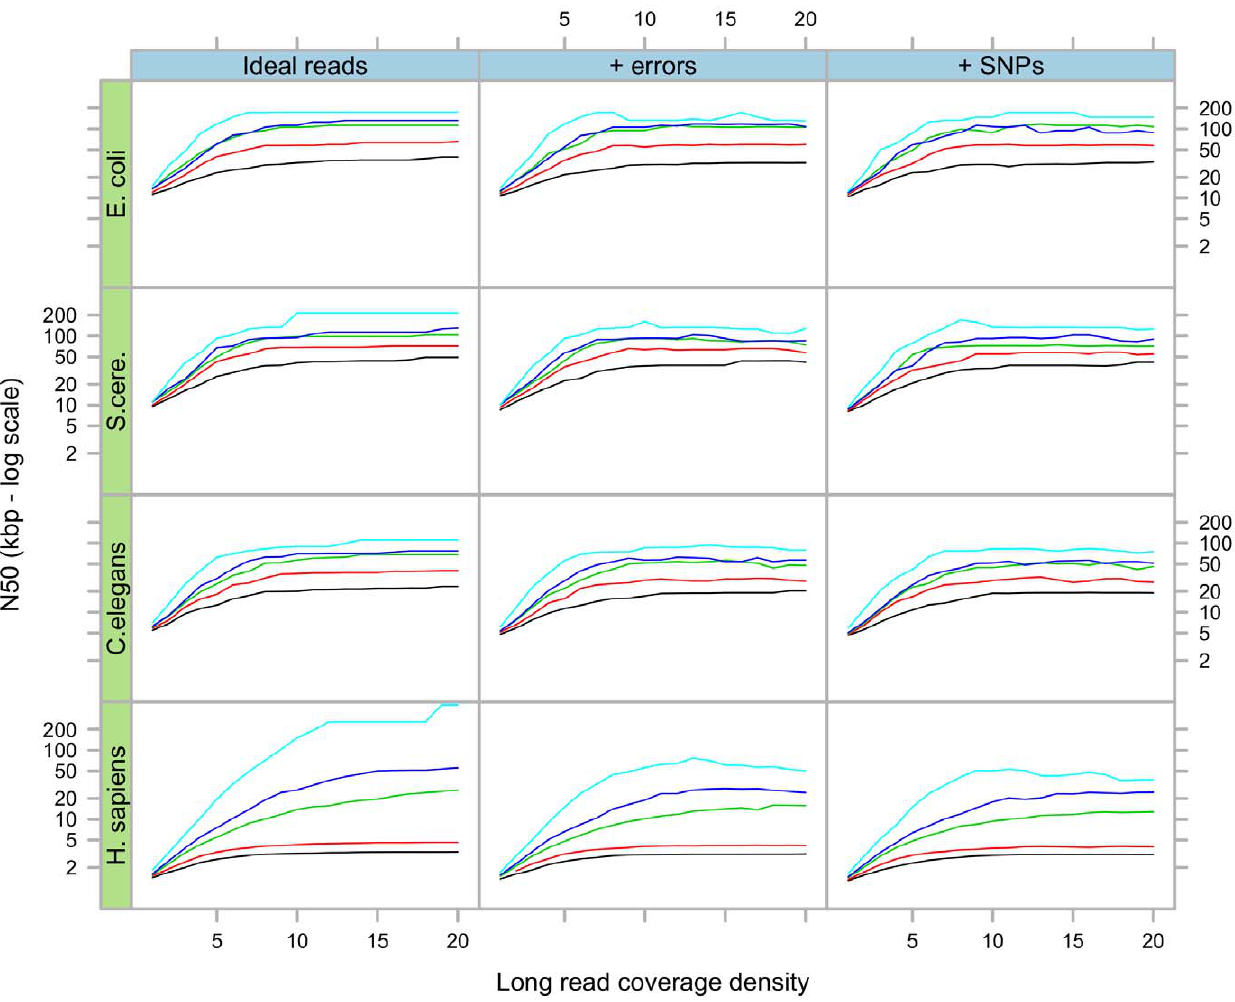
Figure 4. Results of simulations using various long/short read mixtures. Final contig N50 as a function of long read concentration, in four different species, and three different simulation scenarios. The length of the long reads is represented by the colour of the curves: 100 (black) 200 (red) 400 (green) 500 (blue) and 1000 bp (light blue).